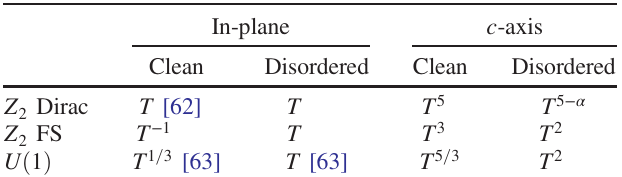
TABLE I. In-plane and c -axis thermal conductivity for several types of QSL. Here, Z 2 Dirac refers to a Z 2 QSL with a Dirac spectrum of fermionic fractional excitations, and Z 2 FS is a Z 2 QSL with a Fermi surface of fractional excitations. Note that U ð 1 Þ refers to a spinon Fermi surface coupled to a U ð 1 Þ fluctuating gauge field, and α ¼ 6 Δ (dimensionless) time-reversal (TR) preserving disorder strength [see Eq. (11)]. The result for the clean Z 2 FS case is correct up to logarithmic